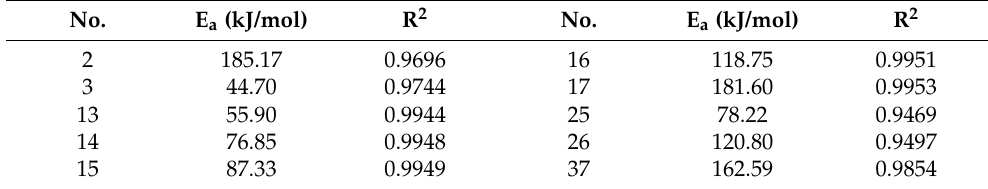
Table 9. Calculated results of TBPTMH with H 2 SO 4 at different G ( α ) by Coats–Redfern method.